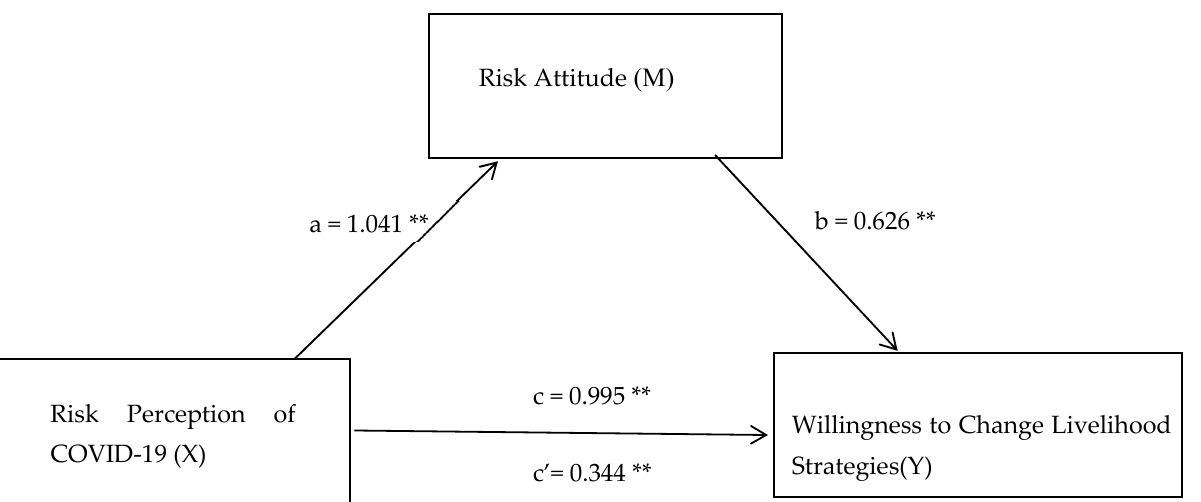
Figure 2. Mediation effects mode. Note: ** p < 0.01; a is effect of Risk perception of COVID-19 on Risk attitude; b is effect of Risk attitude on Willingness to change livelihood strategies; c’ is direct effect of Risk perception of COVID-19 on Willingness to change livelihood strategies; c is total effect of Risk perception of COVID-19 on Willingness to change livelihood strategies.